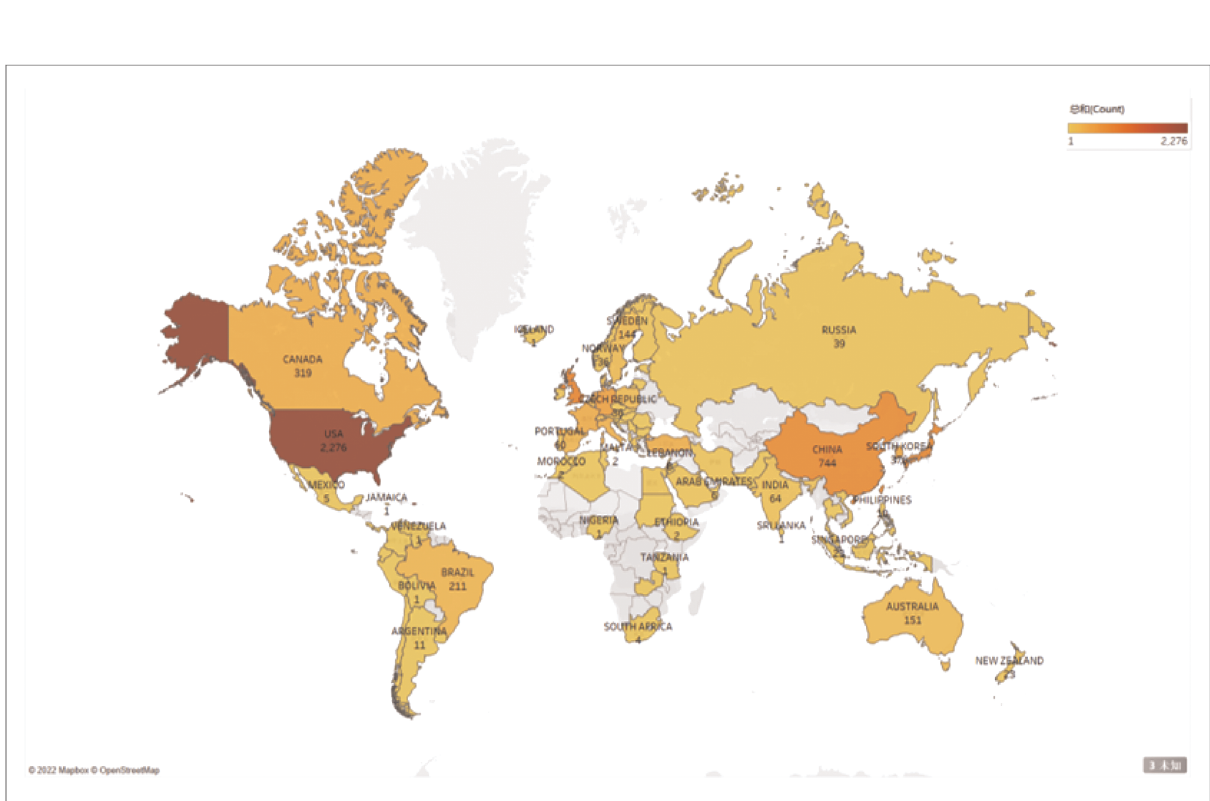
FIGURE 2 Geographic map illustrating the origin of publications in scienti fi c research on overactive bladder in original human